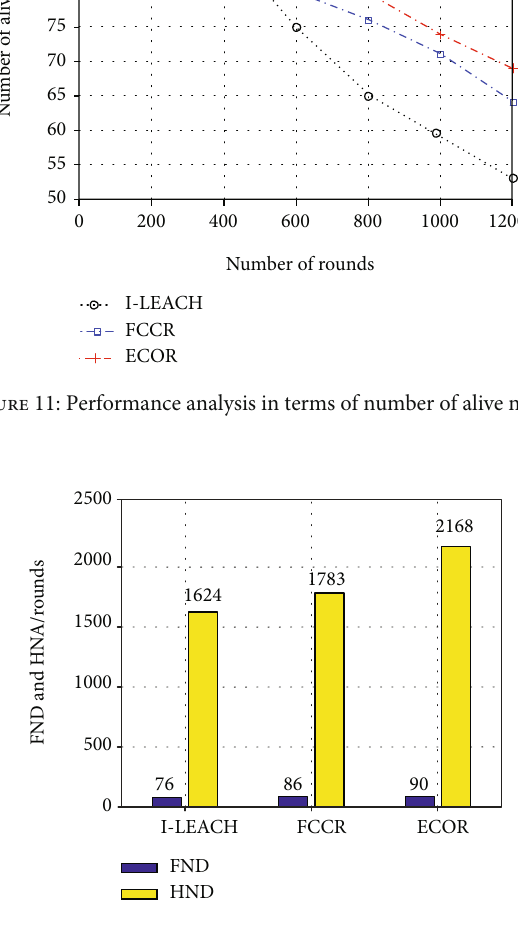
Figure 12: Performance analysis in terms of FND and